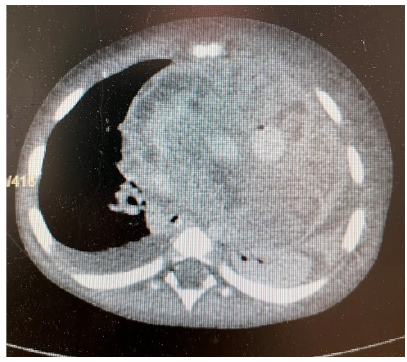
Figure 4. CT aspect of the tumor.